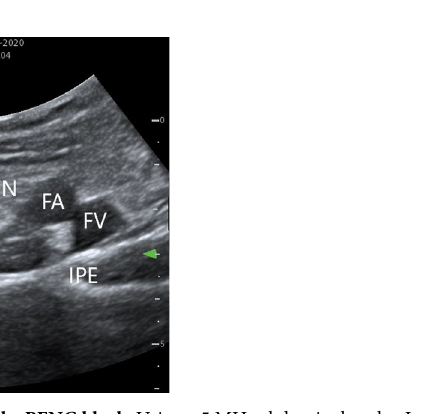
Fig 1. Small axis ultrasound view of the PENG block. Using a 5 MHz abdominal probe. Images from St. Antoine Hospital, Paris.